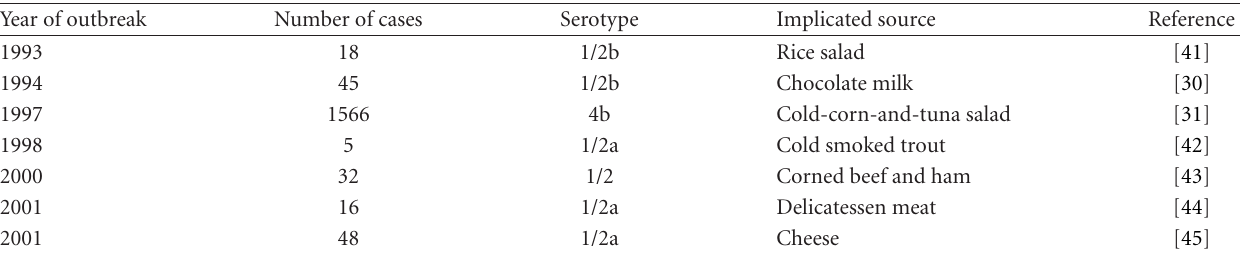
Table 1: Outbreaks of gastroenteritis due to Listeria